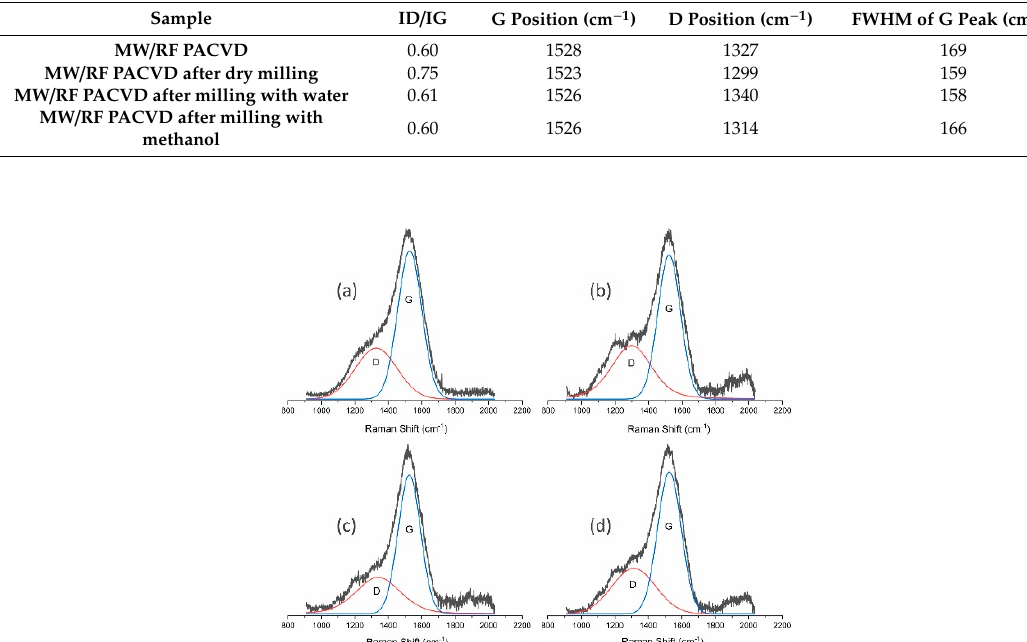
Table 4. Analysis of Raman spectra of powders produced using the CVD method, dry-milled, milled in water, milled in methanol. Figure 4. SEM pictures of powders: ( a ) produced using the chemical vapour deposition (CVD) method; ( b ) dry-milled; ( c ) milled in water; ( d ) milled in methanol.